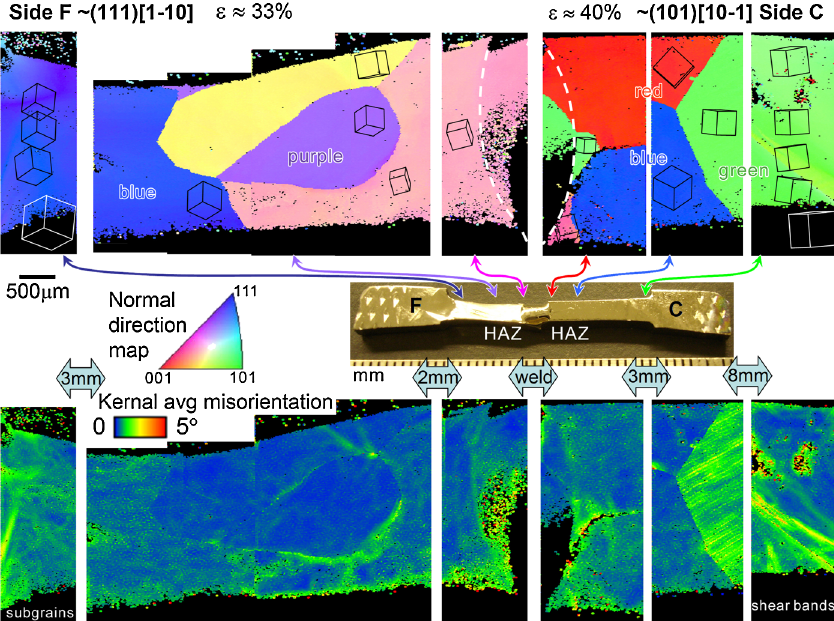
FIG. 16. (Color) Two deformed single-crystal tensile specimens with initial orientations shown with white prisms were deformed to nominally 40% strain, cut in half, and welded together to simulate welding of single-crystal cavities [35]. The specimen recrystallized in the heat affected zone (HAZ), but the temperature gradient halted the recrystallization front about 4 – 5 mm from the